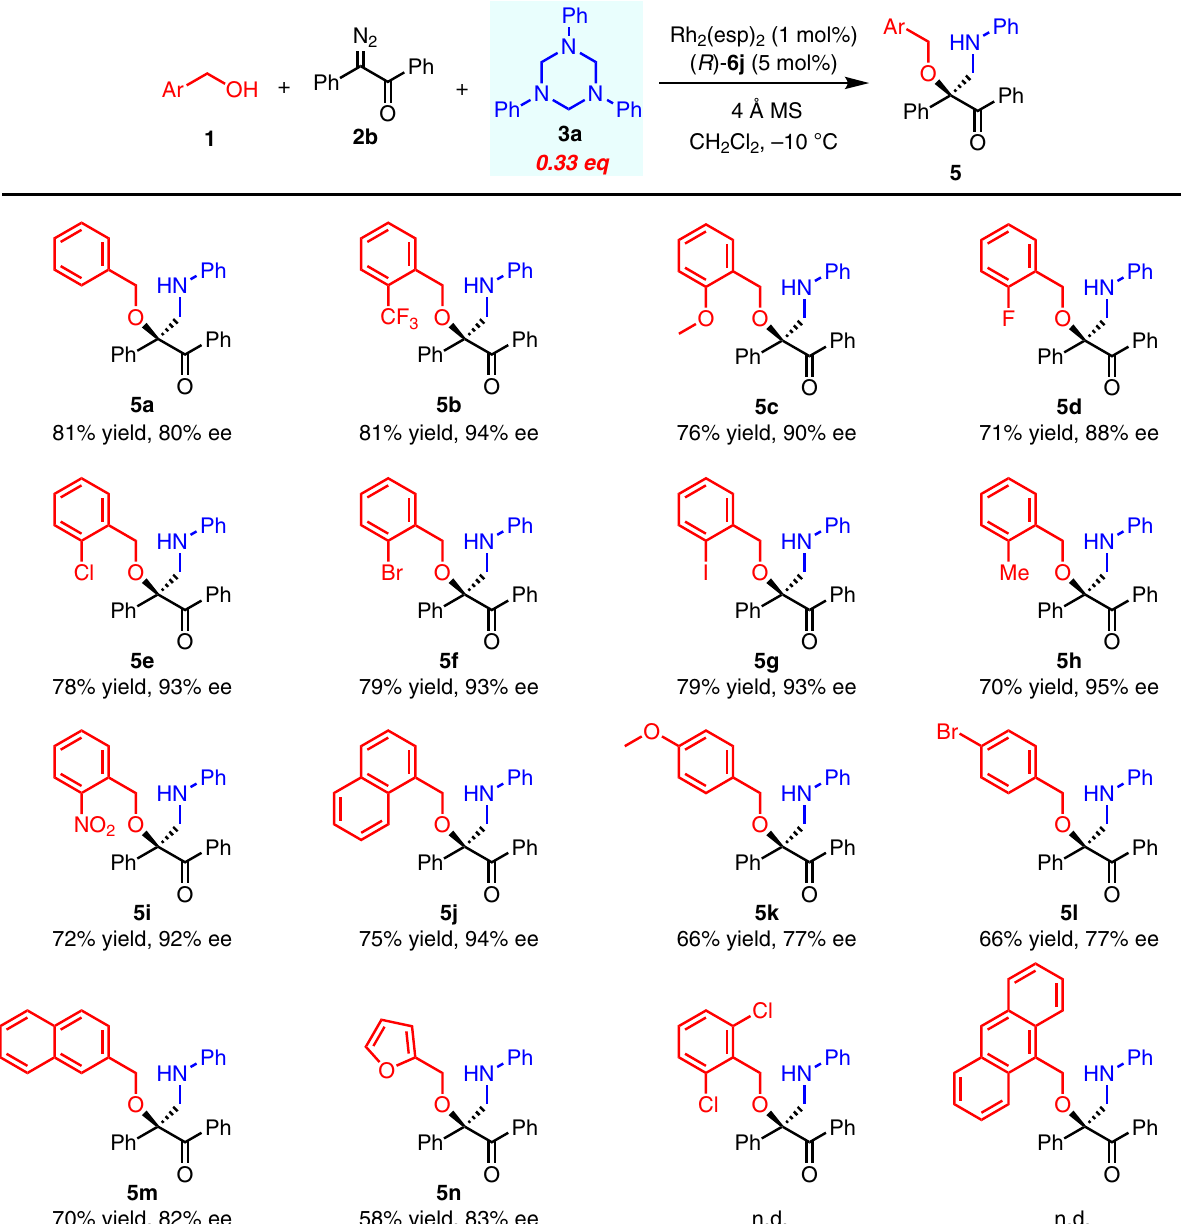
Fig. 2 Substrate scope of benzylic alcohols. All reactions were run in 0.3 mmol scale of 1 , 1 : 2b : 3a = 1/1/0.33. All yields shown were based on isolated products. Ee values were determined by chiral HPLC